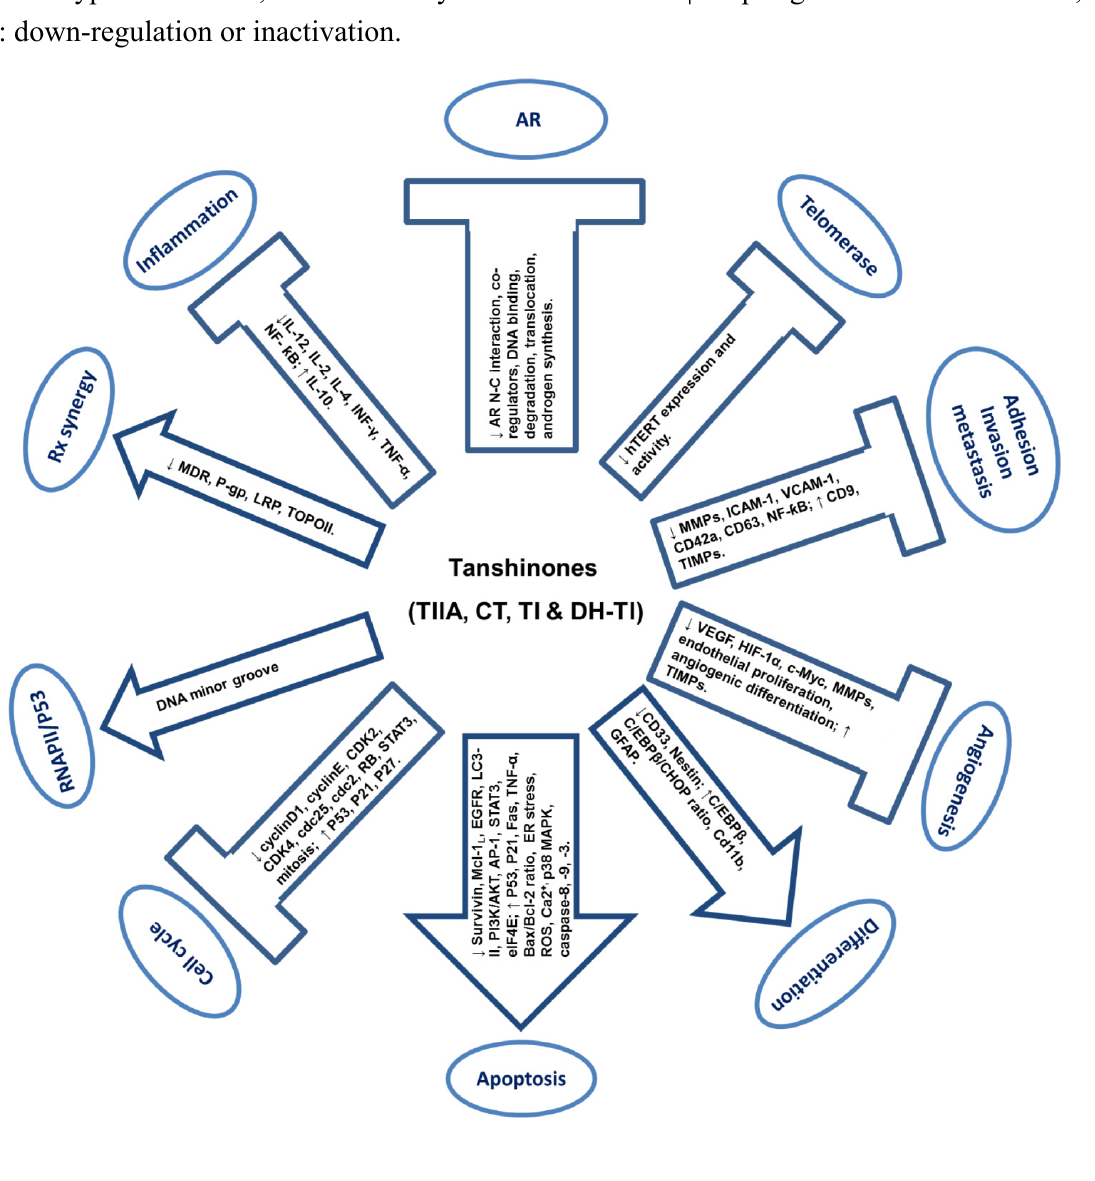
Figure 4. Schematic representations of reported cellular and molecular effects of tanshinones in cell culture models related to cancer. Arrows indicate induction effects. Block T indicates suppression effects. TI: tanshinone I; TIIA: tanshinone